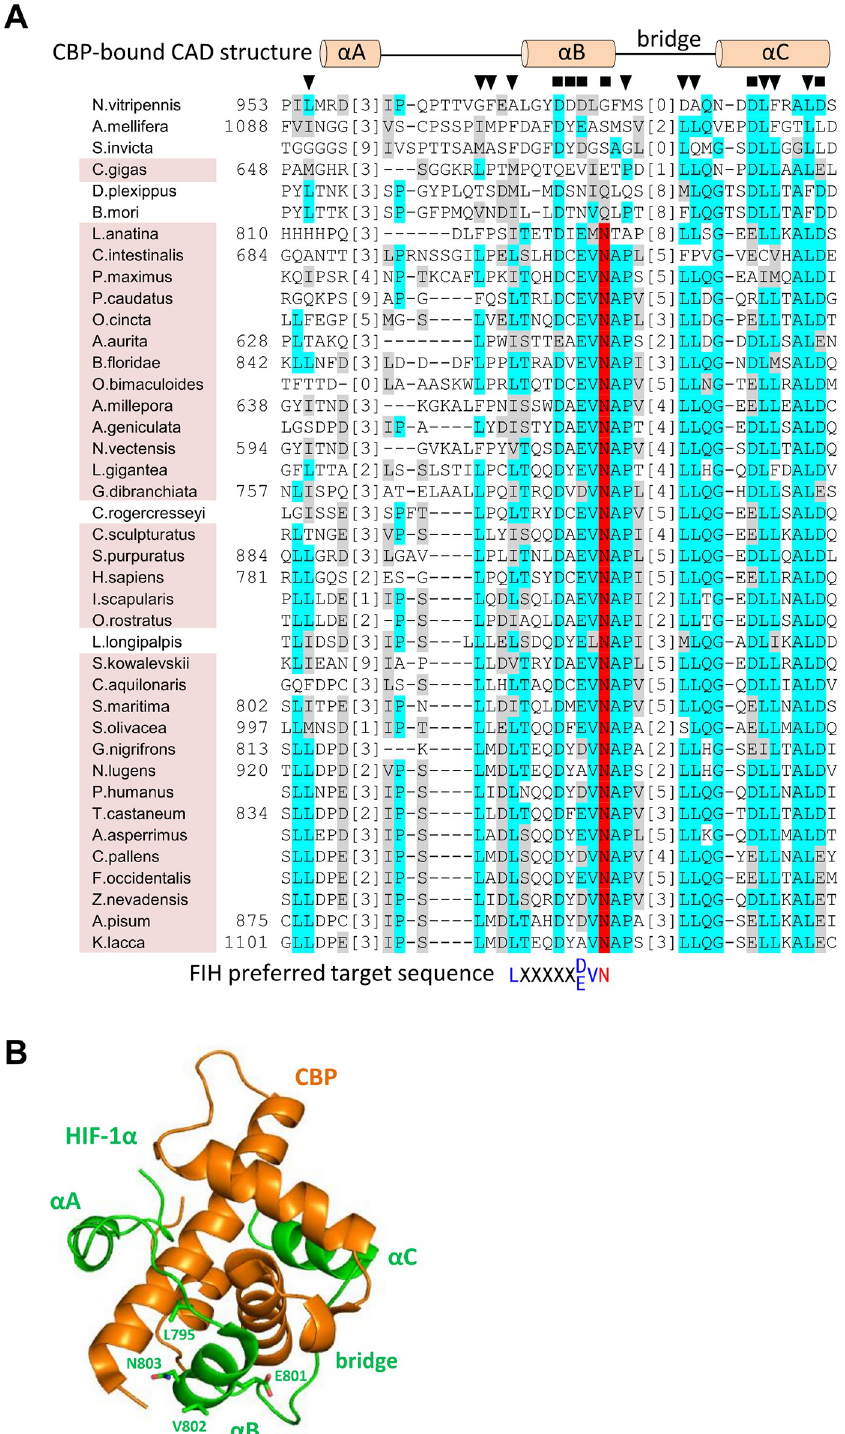
Fig 4. Conservation of CBP and FIH binding residues in HIF- α CAD homologs. (A) Known and putative HIF- α CAD sequences from representative species were aligned using MUSCLE [50]. Identical and similar residues are indicated by cyan and grey highlights, respectively, while likely FIH target Asn residues are highlighted in red. To facilitate viewing of as large a CAD region as possible, low similarity regions of the alignment were deleted and replaced with bracketed numbers which indicate how many residues in each sequence are not shown. Amino